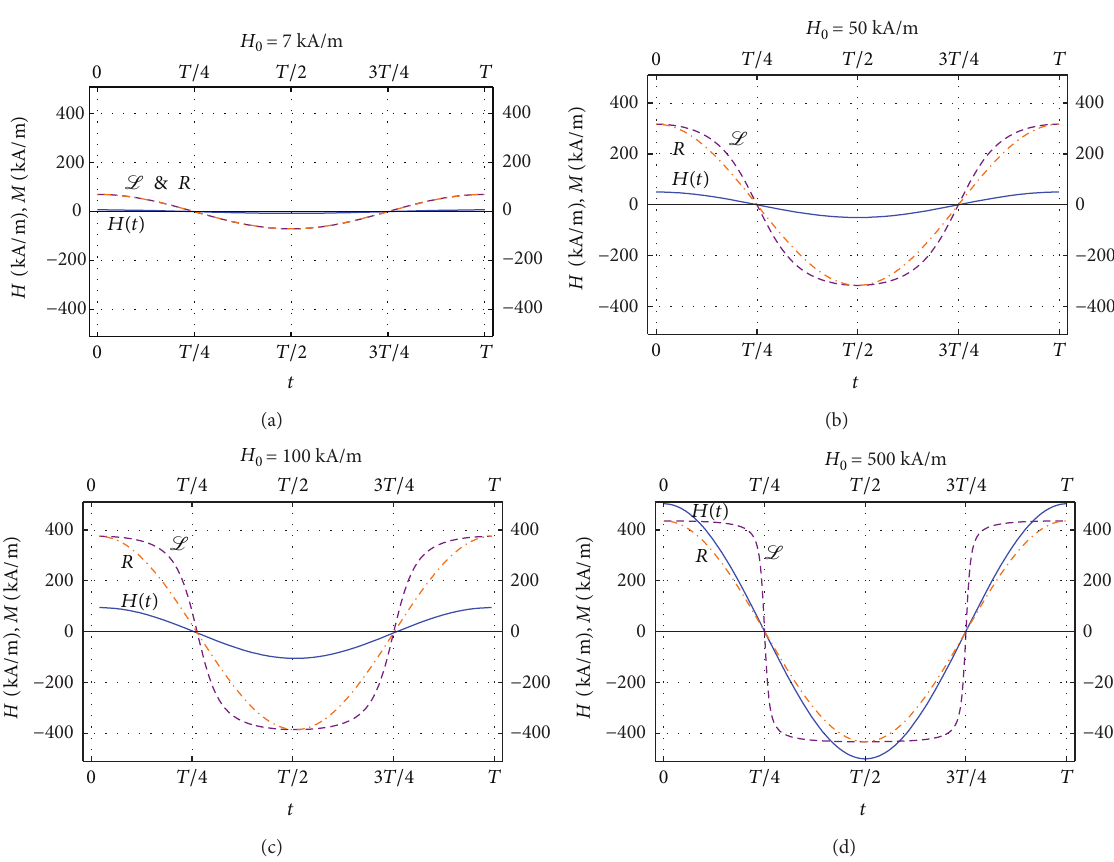
plane to rotate together with the magnetization vector.